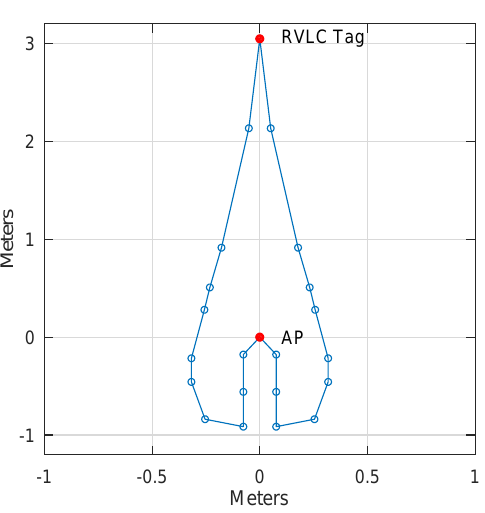
Figure 9. Working range.